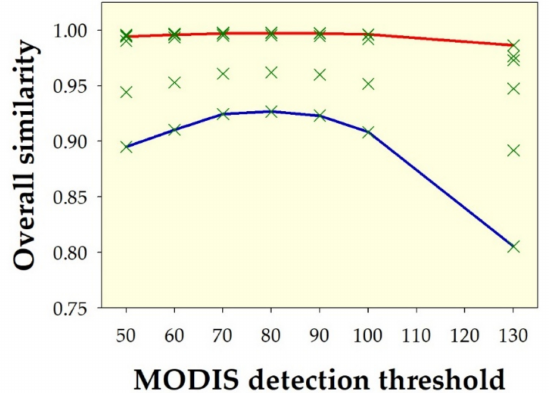
Figure 16. Overall similarity (i.e., the average of θ and δ similarities) of the spatial pattern between deforestation hotspots in Indonesia in 2020, derived from Landsat-8 OLI (at clarity ≥ 50% and deforestation intensity ≥ 50%) and deforestation hotspots in Indonesia in 2020 derived from MODIS (at change-detection thresholds ranging from 50 to 130). Green crosses indicate overall similarity from all nine metrics. Red lines on the upper edge of the envelopes indicate the overall similarity using the Fidelity metric. Blue lines on the lower edge of the envelopes indicate the overall similarity using the metric of